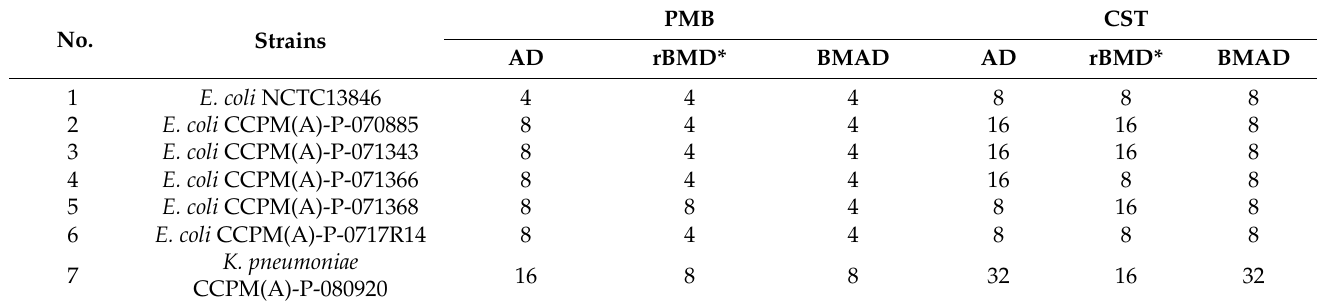
Table 2. MIC values ( µ g/mL) of polymyxin B and colistin for mcr-1 positive isolates.